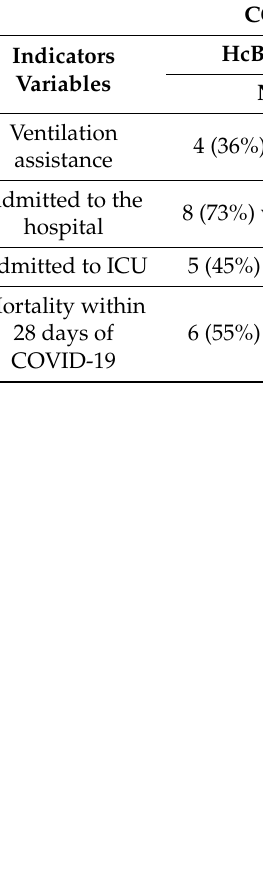
Table 5. Summary of variable values for control and prednisone groups.